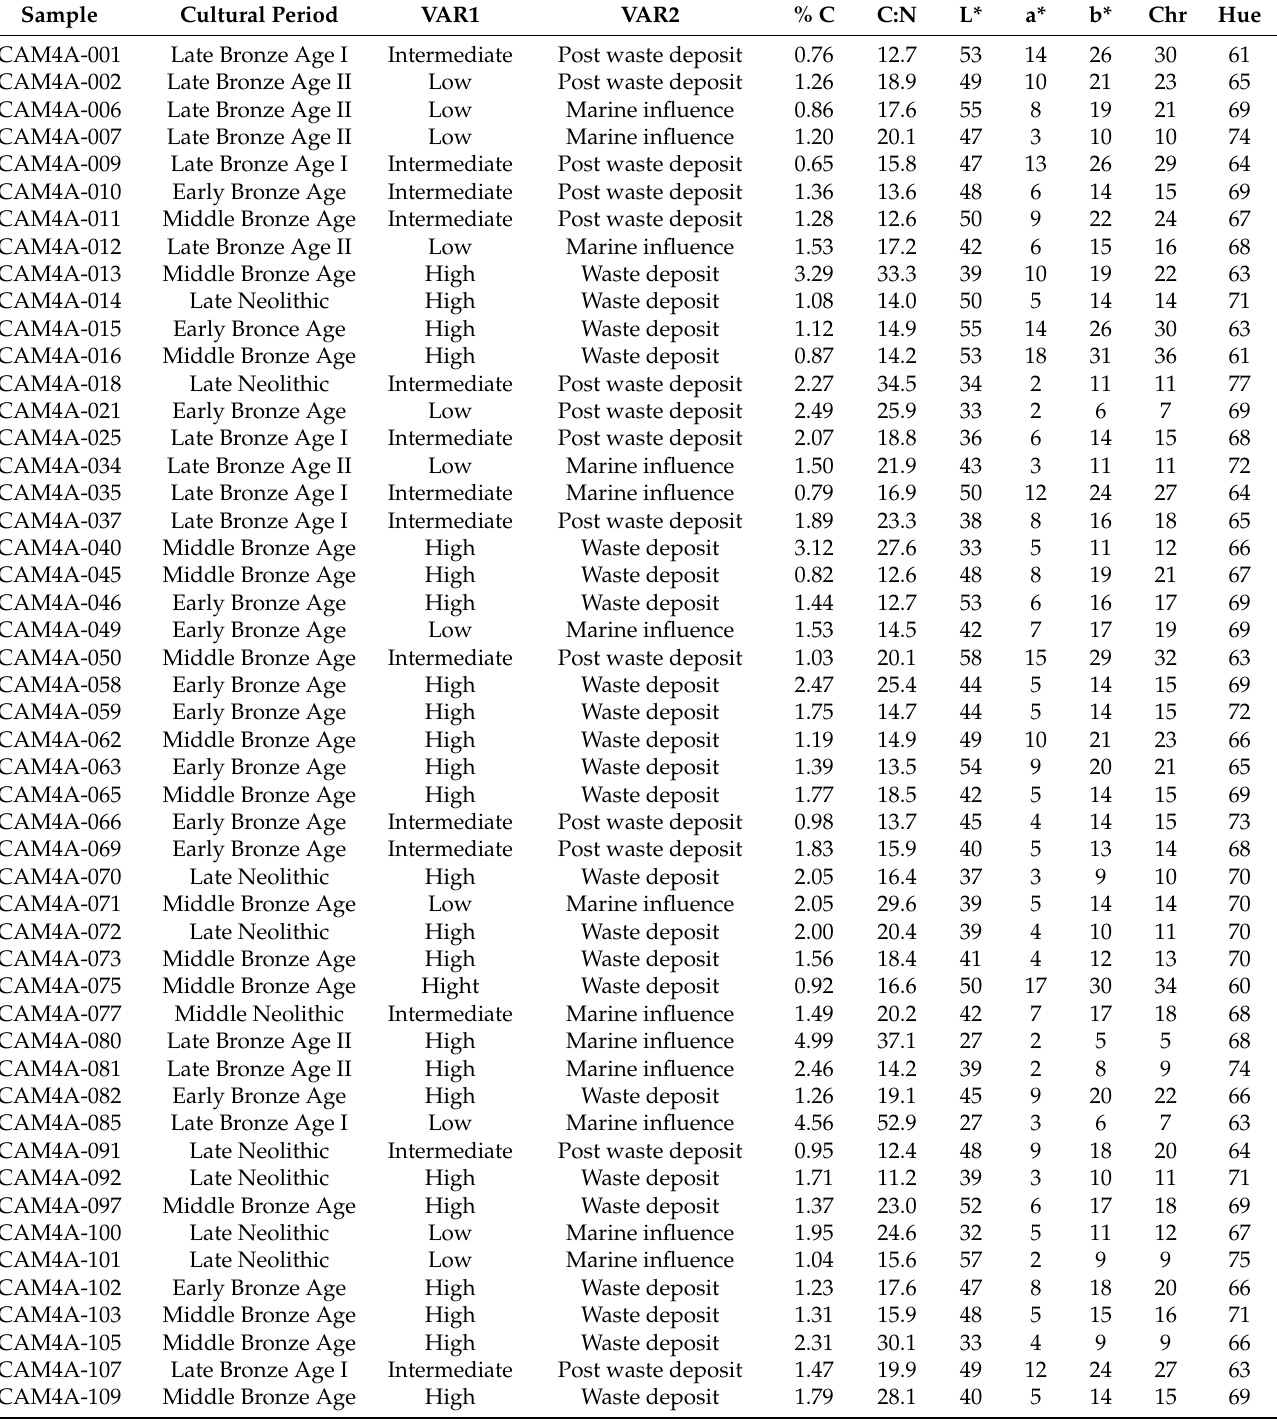
Table 1. Sample codes, cultural period and possible sources of contamination (VAR1 and VAR2, see Section 3.3). Continuous variables correspond to elemental analysis (%C, molar C/N) and CIELAB color parameters for luminosity (L*), redness (a*), yellowness (b*), chroma (Chr) and